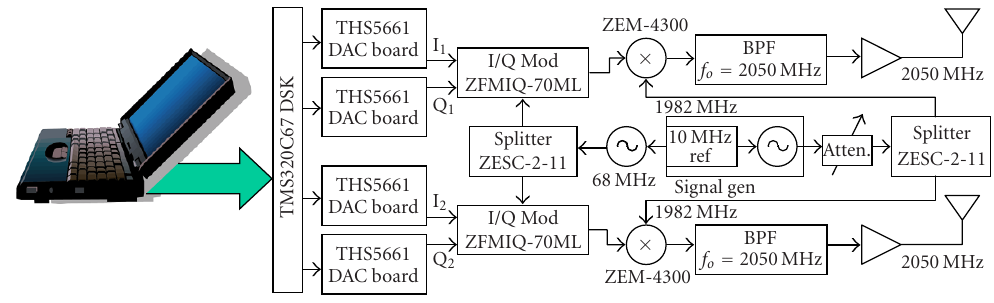
Figure 2: Transmitter architecture.